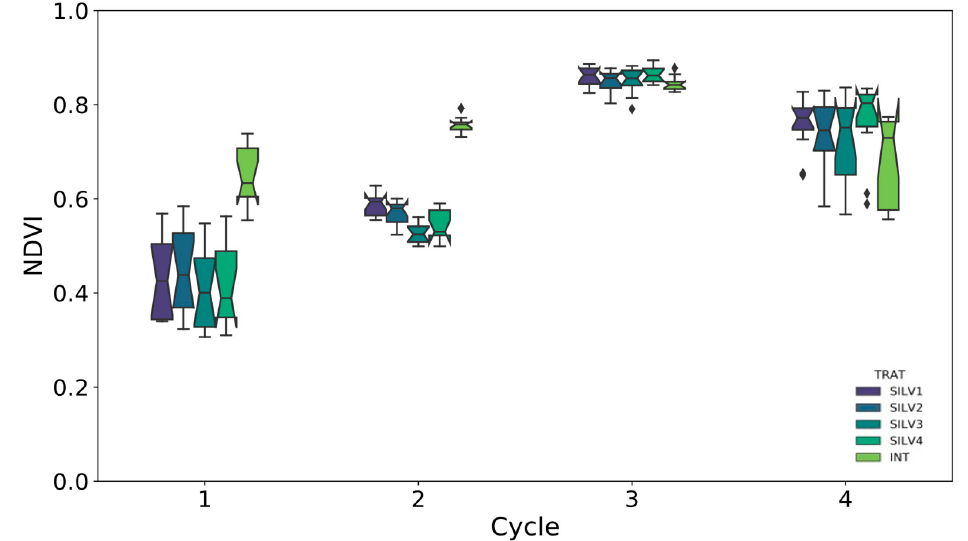
Figure 5. NDVI boxplots at four levels of shading of SILV (SILV1 to SILV4) and INT for the four evaluated forage cycles.